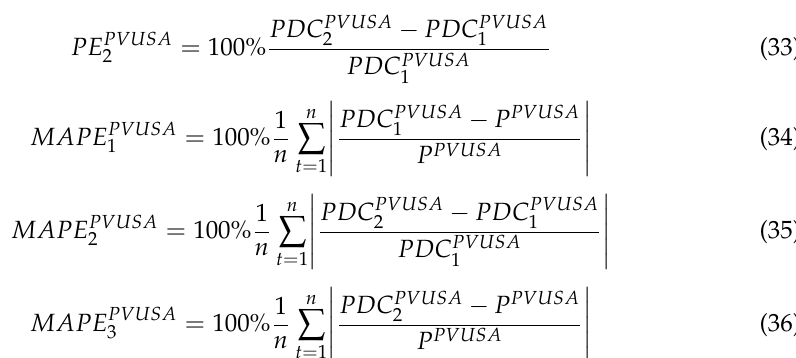
Table 4. MAPE for monocrystalline, polycrystalline, and thin-films modules, under PVUSA con- ditions ( PVUSA ). MAPE PVUSA relates to the error between PDC PVUSA 1